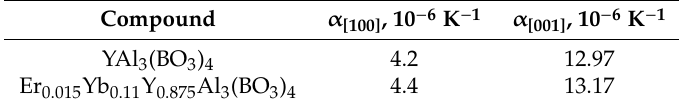
Table 2. Linear thermal expansion coe ffi cients of YAB and (Er,Yb):YAB solids [38].